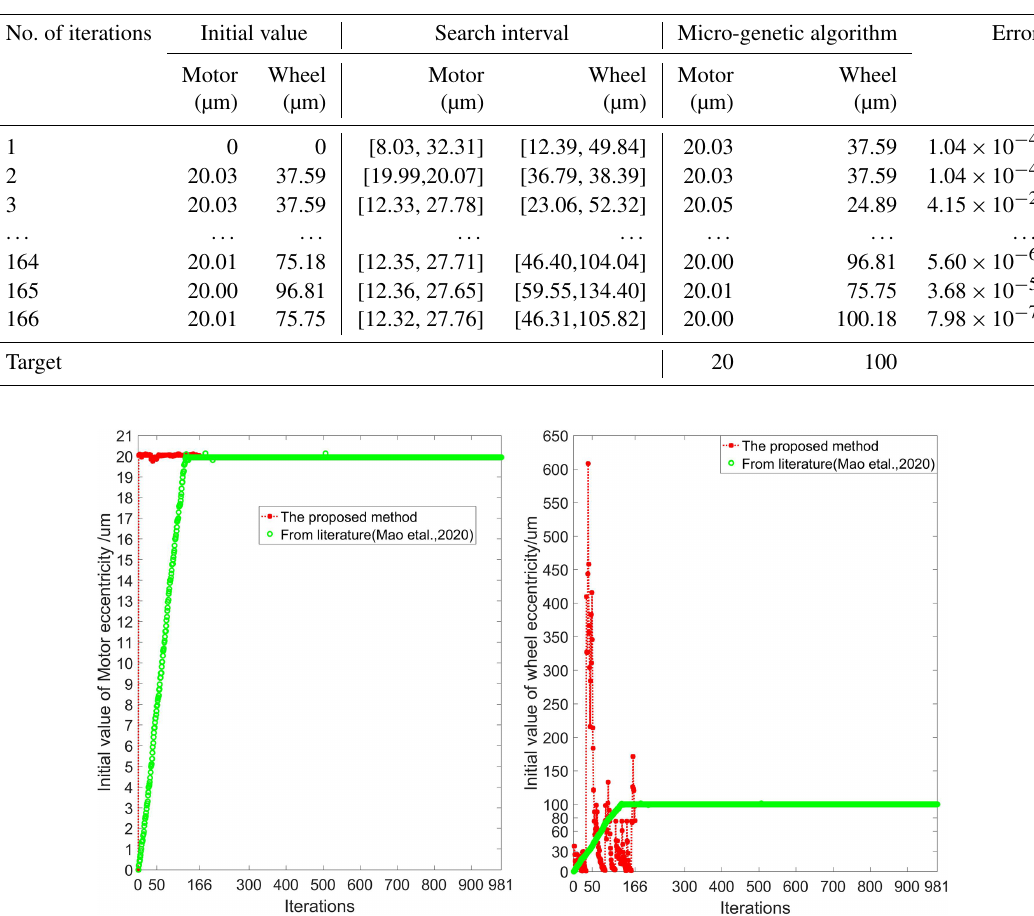
Table 2. Solution procedure to the eccentricity.